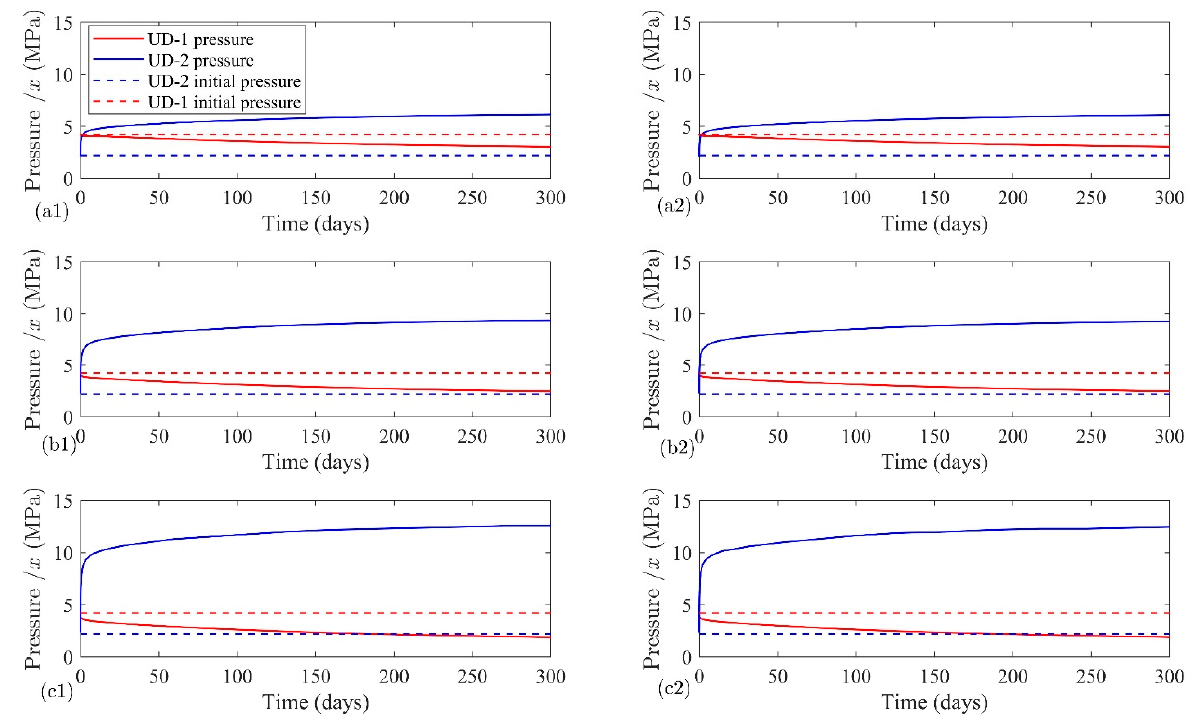
Figure 10. Simulated pressures at the injection and production wells for injection flow rate of ( a1 , a2 ) x L/s, ( b1 , b2 ) 2 x L/s and ( c1 , c2 ) 3 x L/s. The left panels are plotted for a hydraulically stimulated region that spans over 25 m, whereas it is 50 m for the right panel.